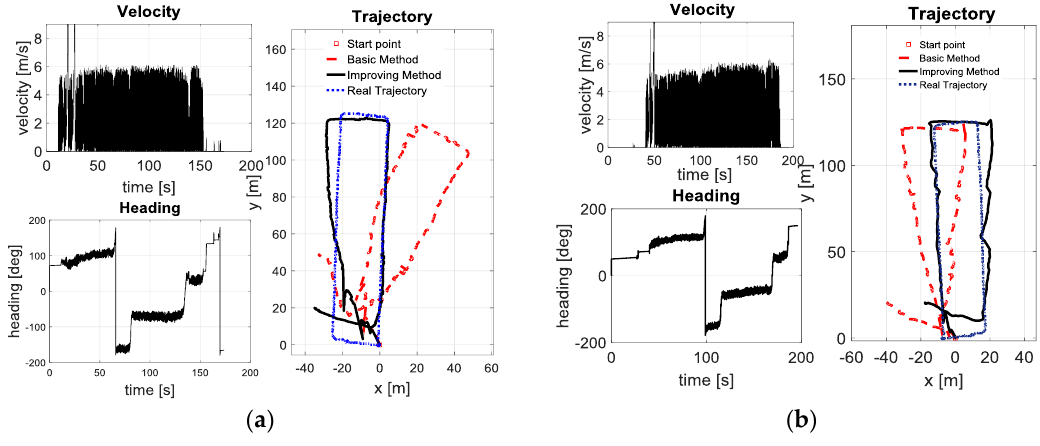
Figure 12. Long-distance running test results: ( a ) Test 1; ( b ) Test 2.